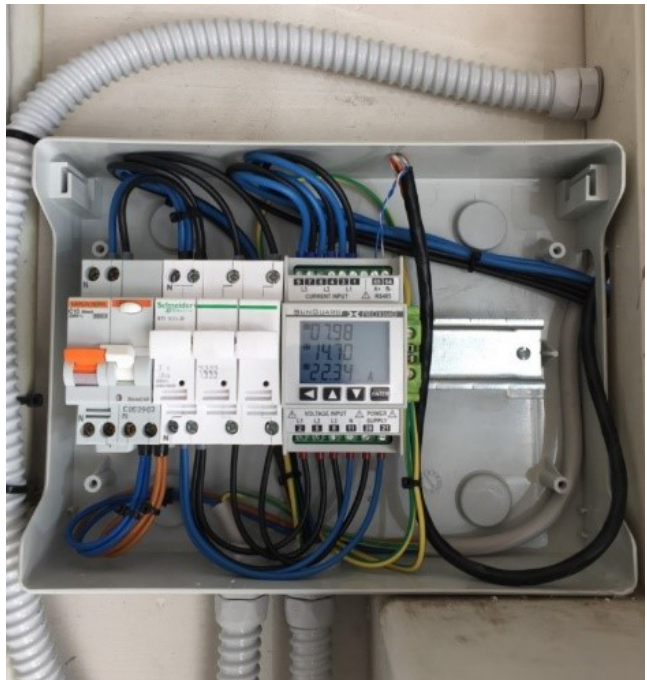
Figure 3. Installation of a compact multi-function network analyzer in a junction box (pilot system in